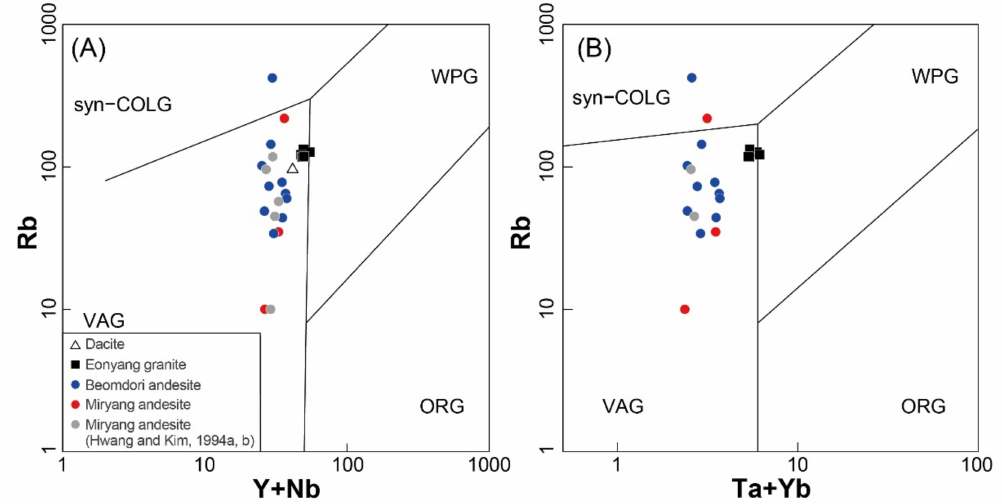
Figure 18. Tectonic discrimination diagrams with discrimination fields after [26] for the analyzed samples. ( A ) Rb-(Y+Nb) diagram; ( B ) Rb-(Ta+Yb) diagram. Abbreviations: syn-COLG, syn-collisional granites; VAG, volcanic arc granites; WPG, within-plate granites; ORG, ocean-ridge